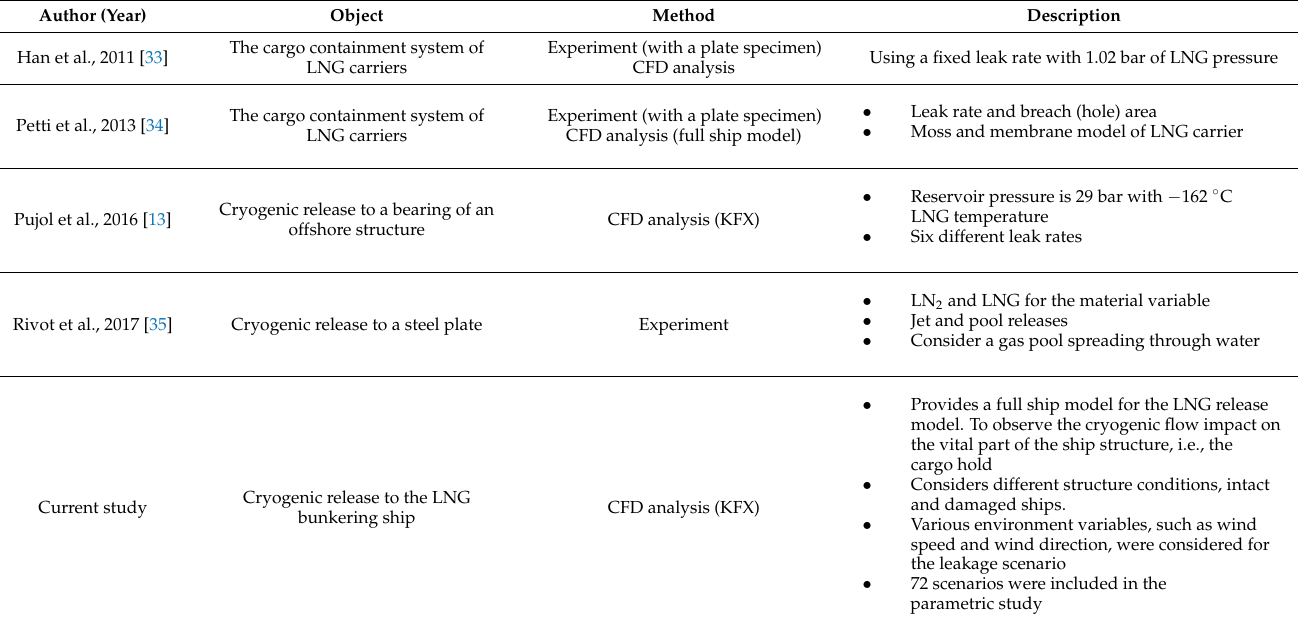
Table 1. Temperature reduction analysis of cryogenic release in several past studies.